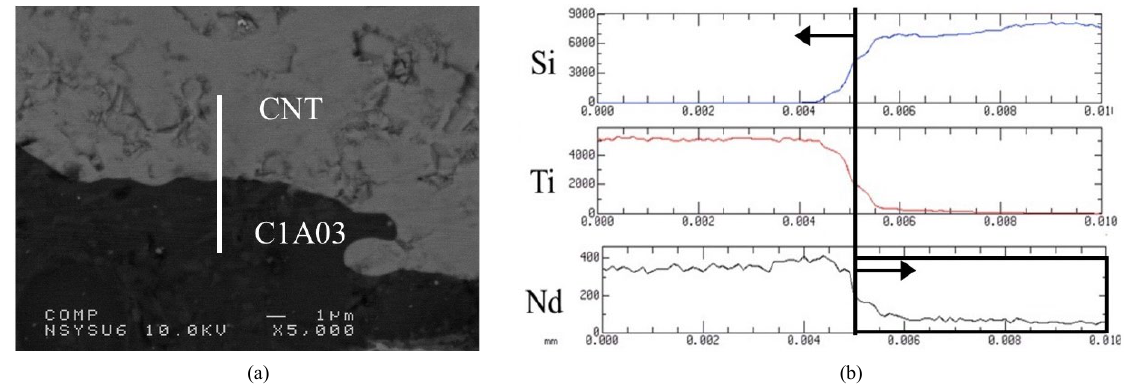
Fig. 4 (a) SEM image and (b) concentration profiles of the interface between Ca 0.7 Nd 0.2 TiO 3 ceramics and C1A03 glass sintered at 900 ℃ for 1